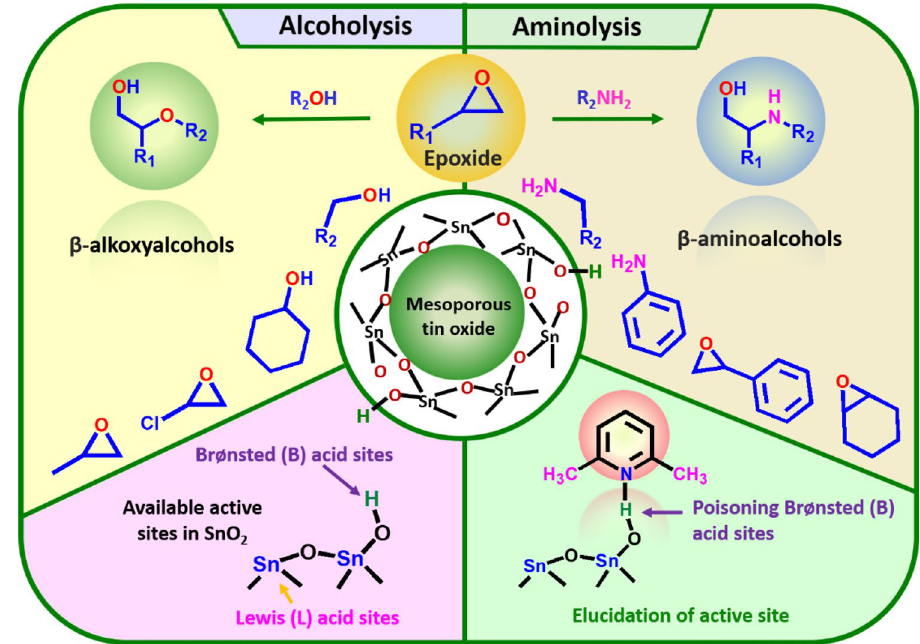
Figure 5. Graphical representation of alcoholysis and aminolysis reactions of epoxides catalyzed by mesoporous tin